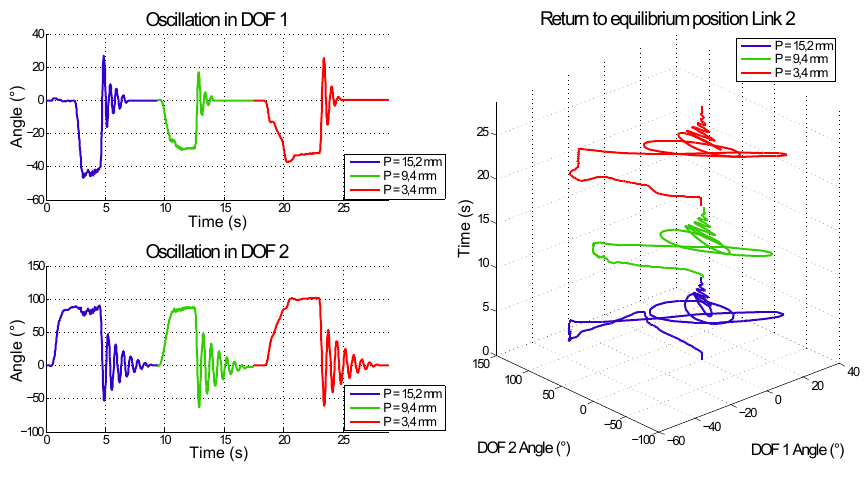
Induced passive oscillations for equilibrium position ( φ different pre-tensions.